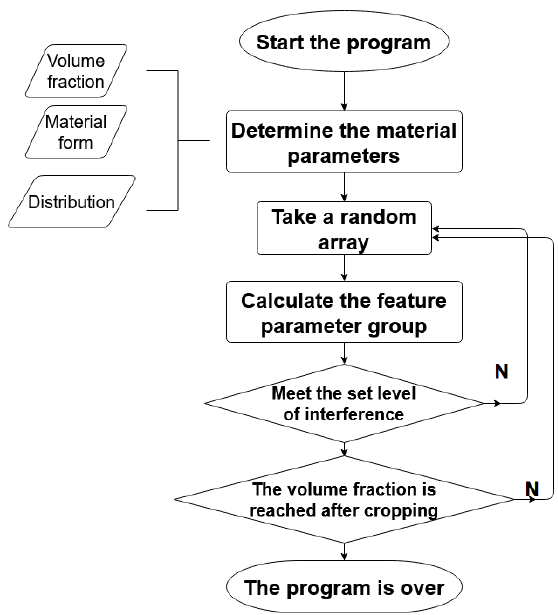
Figure 2. Automatically generated algorithm flowcharts for RVE models.